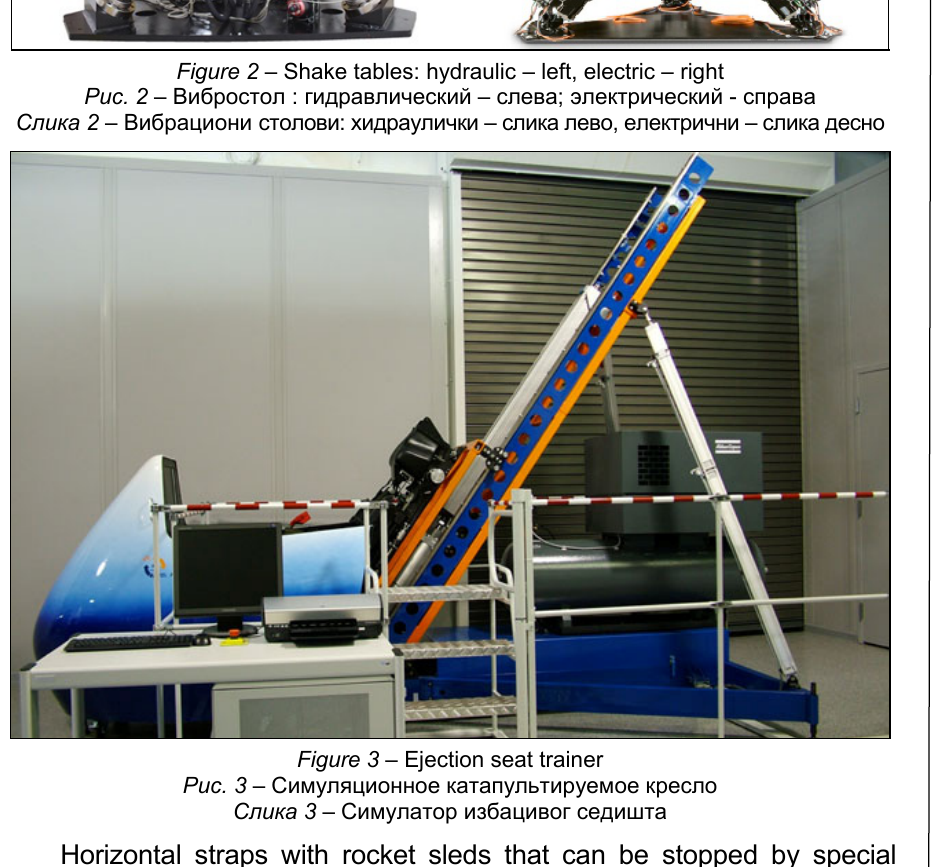
Figure 3 – Ejection seat